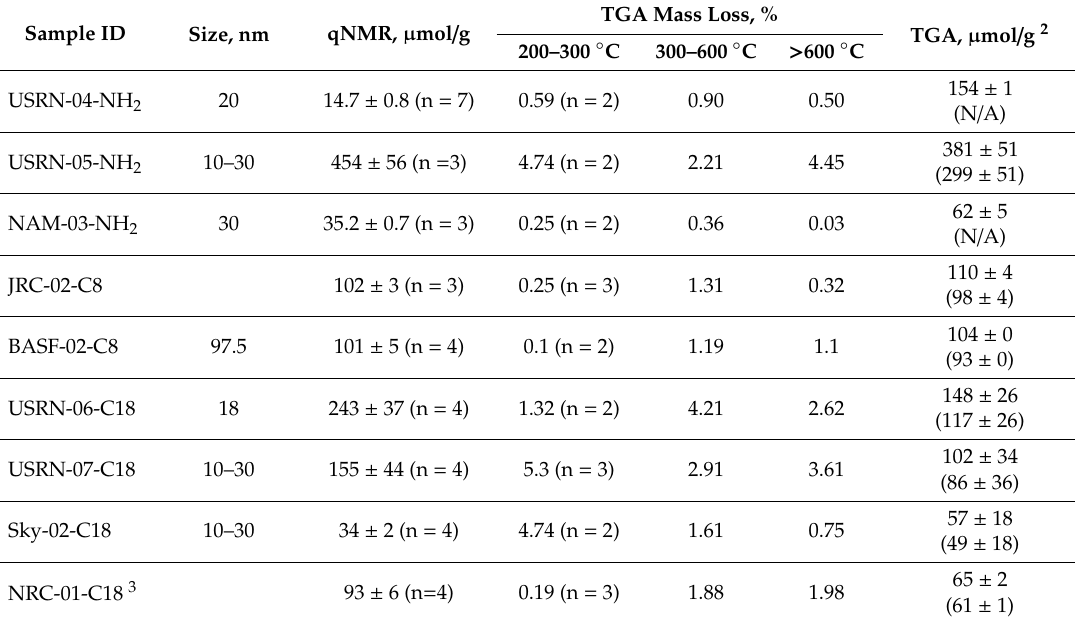
Table 2. Quantification of surface coatings on ZnO NPs by qNMR and TGA.